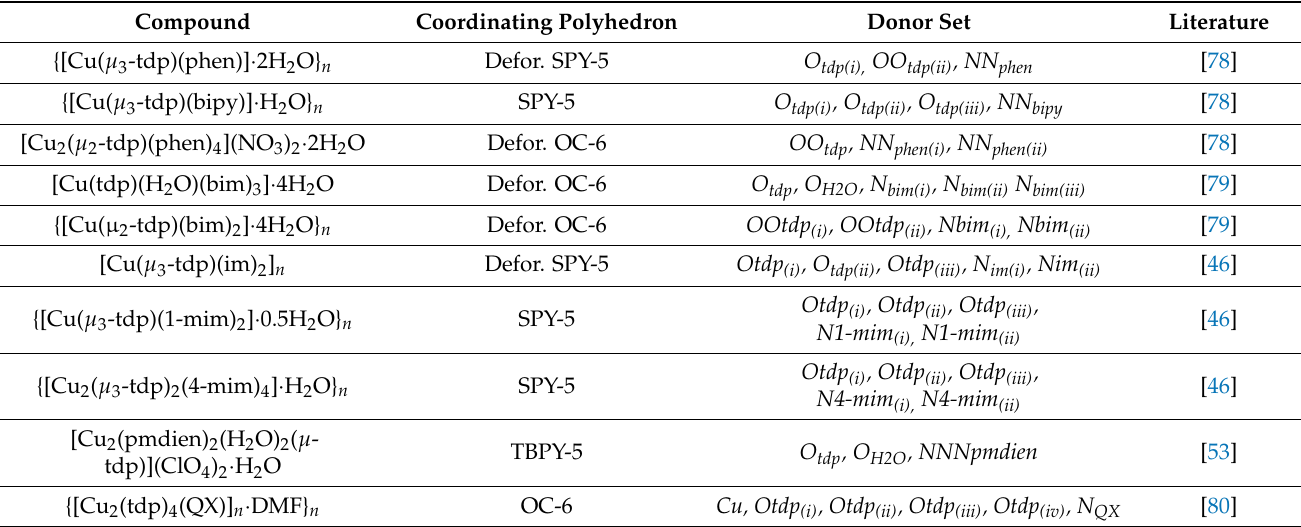
Table 2. Summary of structurally characterized copper complexes with 3,3 1 -thiodipropionic acid and N donor